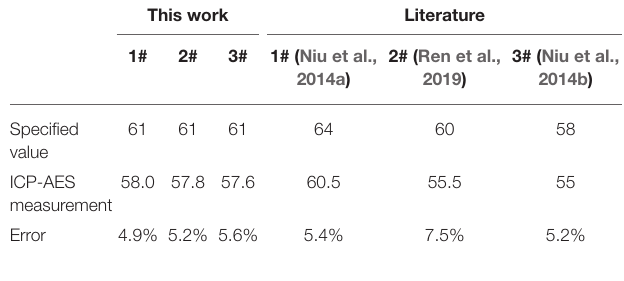
TABLE 3 | Li content of the Li-B alloy (wt.%).